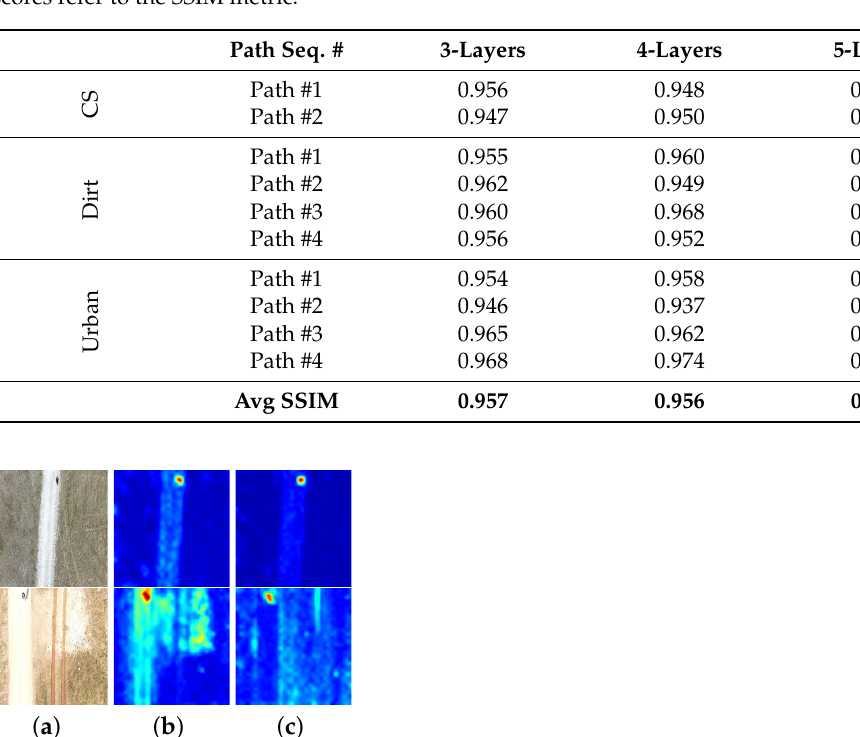
Table 4. Performance evaluation of localizer L obtained by changing its number of layers. Reported scores refer to the SSIM metric.